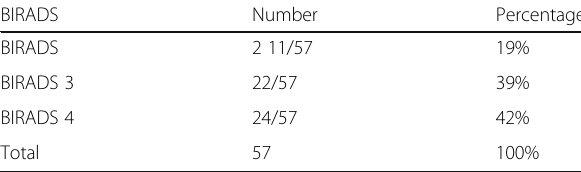
Table 3 The BI-RADS categories by mammography BIRADS Number